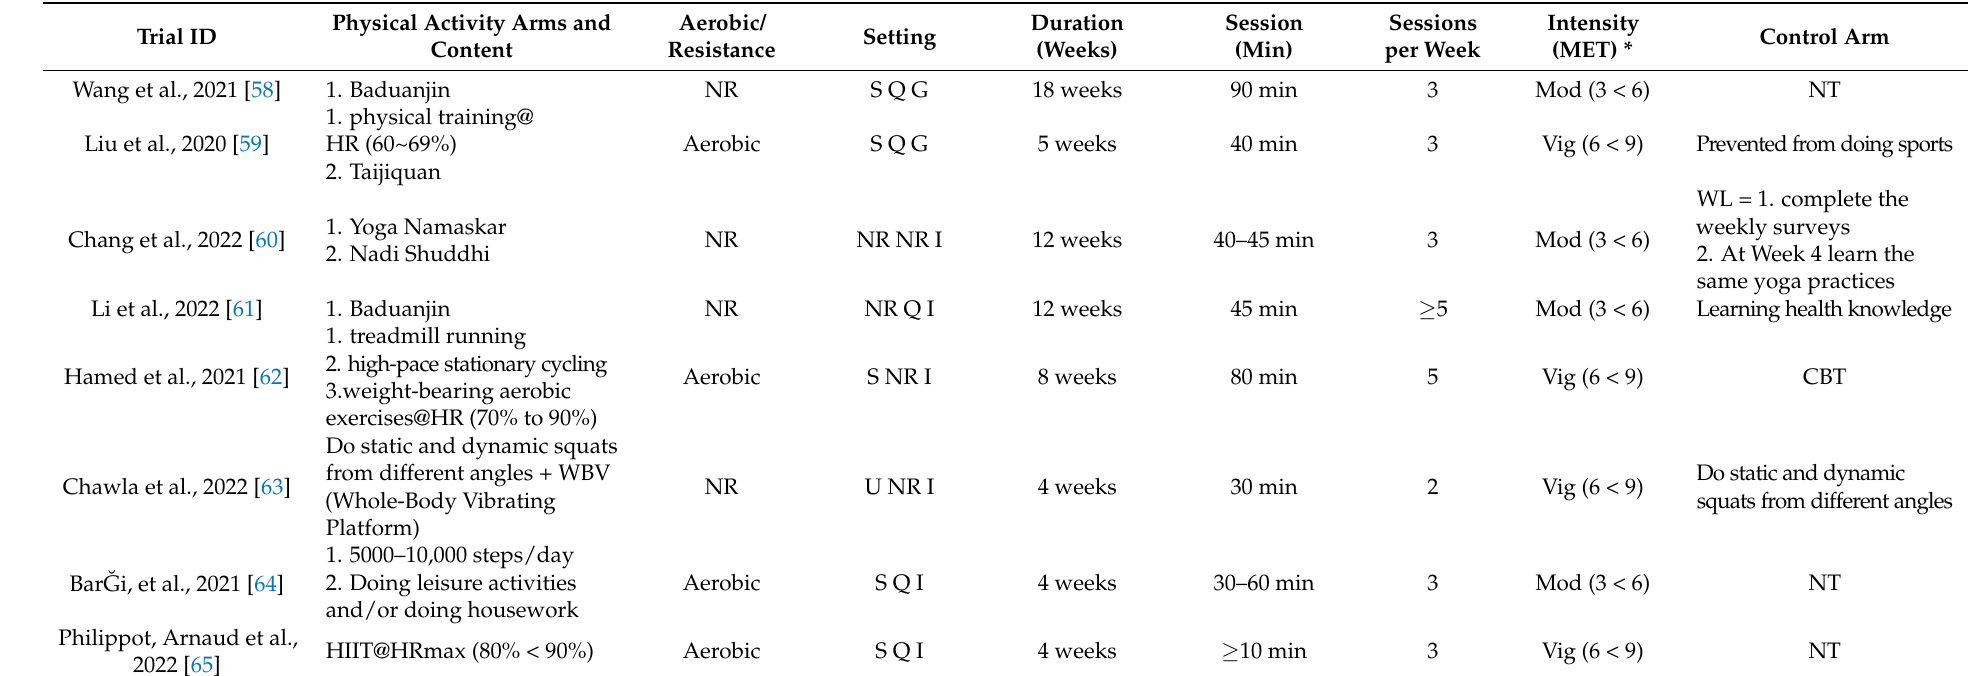
Table 3. Characteristics of physical activity interventions from included